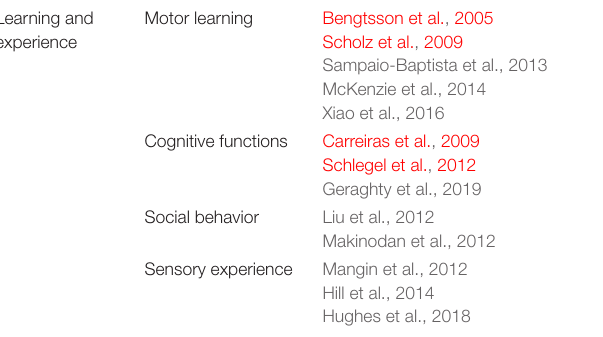
Table recapitulating the most relevant studies linking myelin modifications with learning, social behavior and sensory experience. Human studies are indicated in red, while rodent studies are indicated in